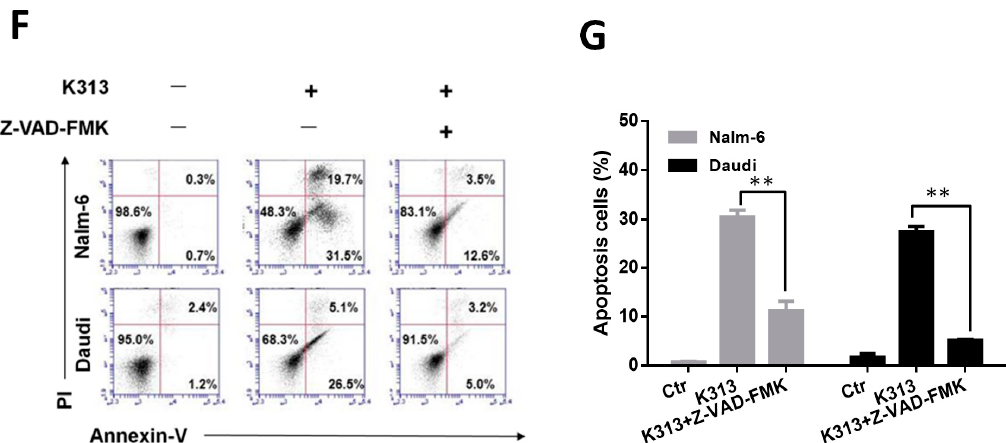
Figure 3. K313 induces apoptosis in Nalm-6 and Daudi cells. ( A ) Nalm-6 and Daudi cells were incubated with varying concentrations of K313 for 48 h. Cells were harvested and incubated with Annexin V-FITC and PI and then analyzed using flow cytometry (FCM). ( B ) The percentage of apoptotic cells was evaluated in Nalm-6 and Daudi cells. ( C ) Nalm-6 and Daudi cells were treated with K313 (0, 4, 8, and 16 µ M) for 48 h. The cells were harvested and the whole protein lysates were subjected to Western blot analysis. The apoptotic protein expression levels in ( D ) Nalm-6 and ( E ) Daudi cells were quantified by Quantity One software. ( F ) Nalm-6 and Daudi cells were treated with 20 µ M K313 only or a combination of 20 µ M K313 and 50 µ M Z-VAD-FMK (an irreversible pan-caspase inhibitor), and the cells were harvested and incubated with Annexin V-FITC and PI and analyzed by FCM. ( G ) The percentage of apoptotic cells was quantified in the control (0.2% DMSO), K313 only, and combination of K313 and Z-VAD-FMK. * p < 0.05, ** p < 0.01, and *** p < 0.001 vs. control group.